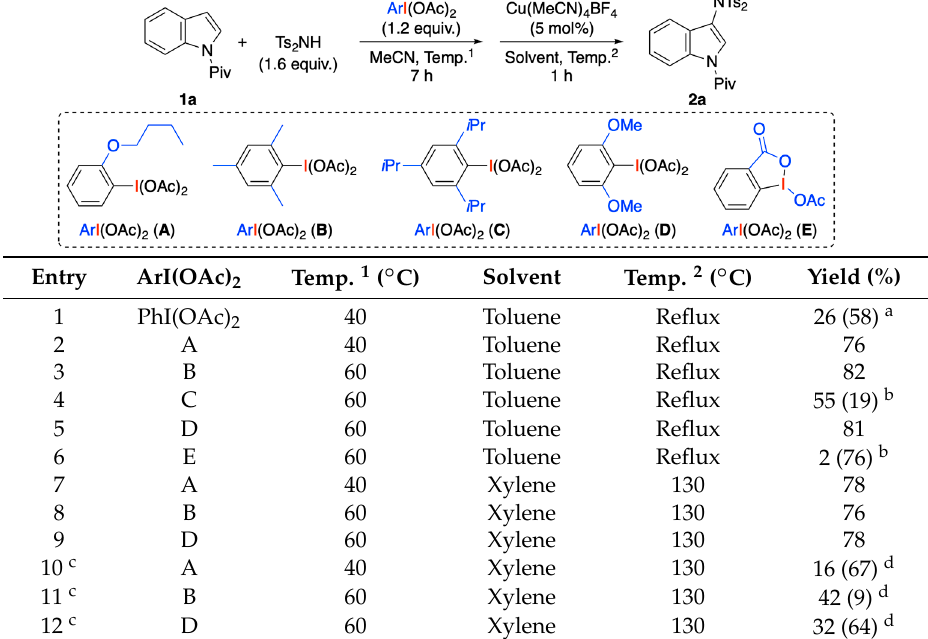
Molecules 2019 , 24 , x FOR PEER REVIEW